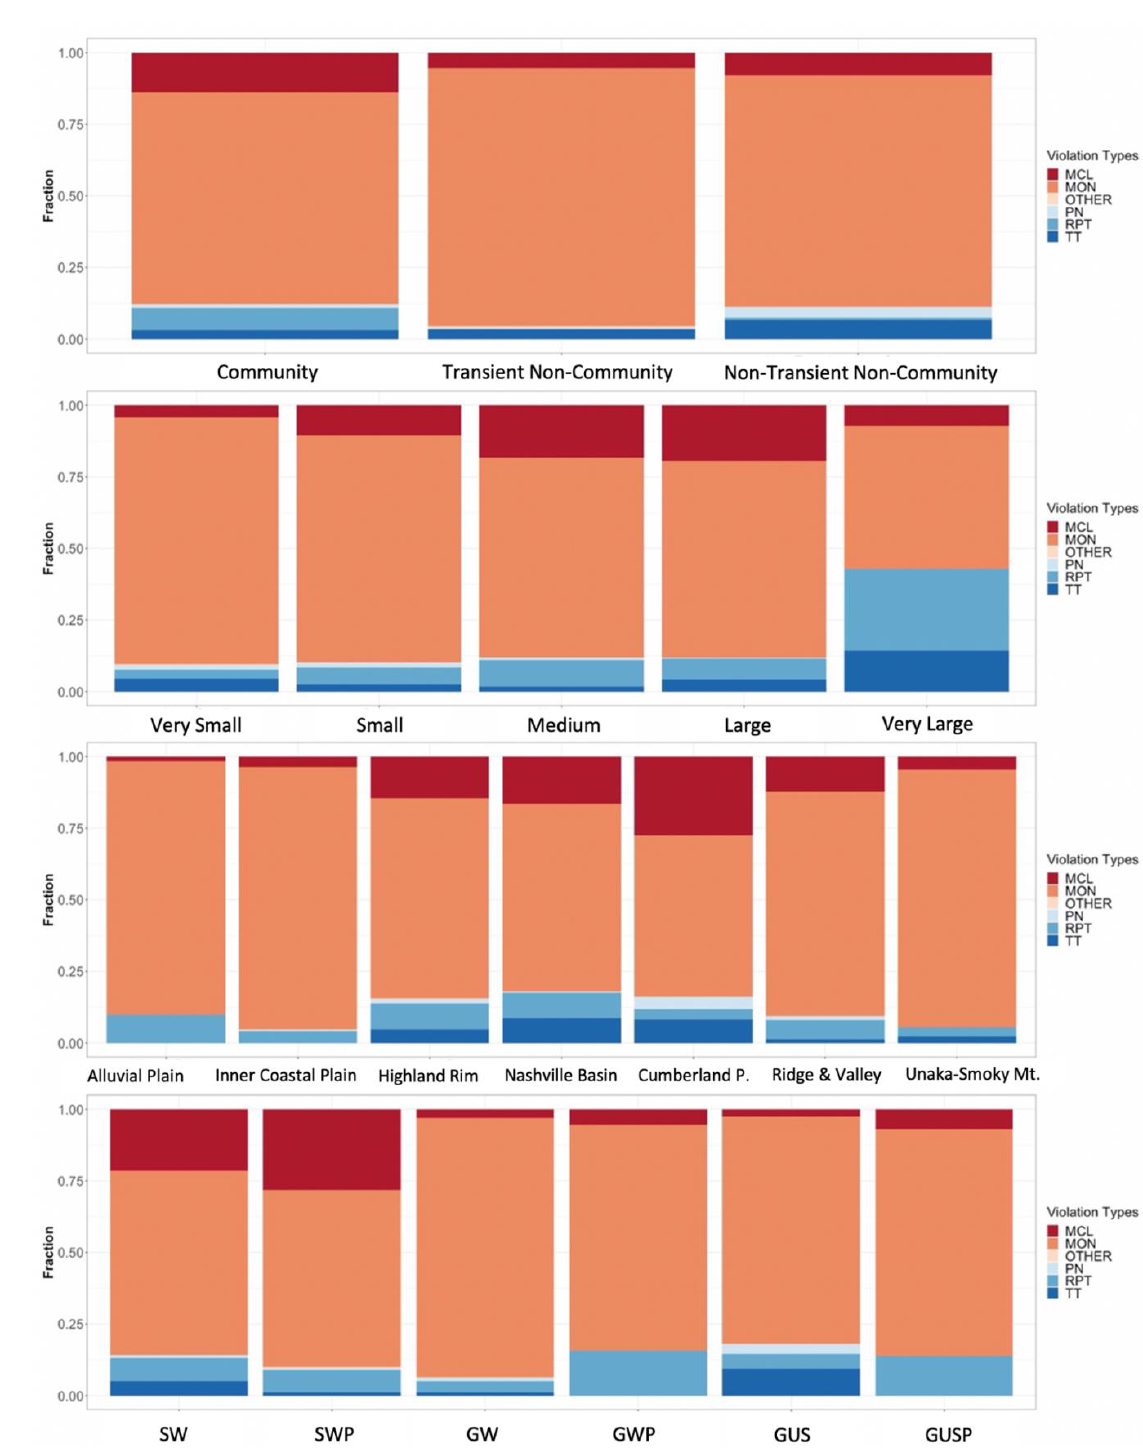
Figure 2. Fractions of the types of violations by ( a ) types of the water systems, ( b ) sizes of the systems, ( c ) geological regions, and ( d ) sources of water. Purchased water, in general, has a higher share of MCL -based violations and fewer TT violations in comparison to systems that treat their own water.